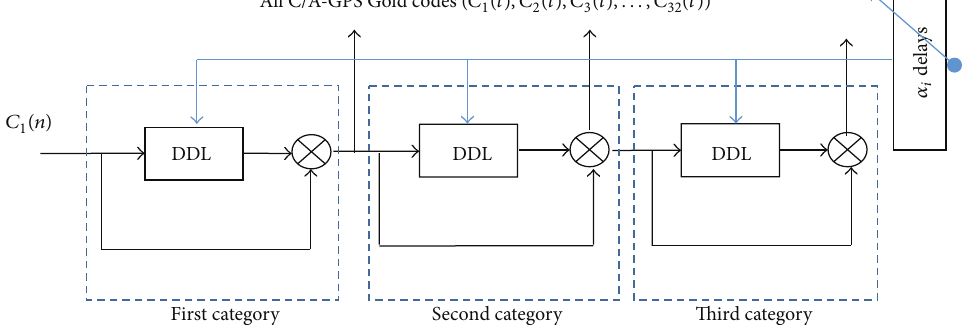
Figure 10: DSP implemented